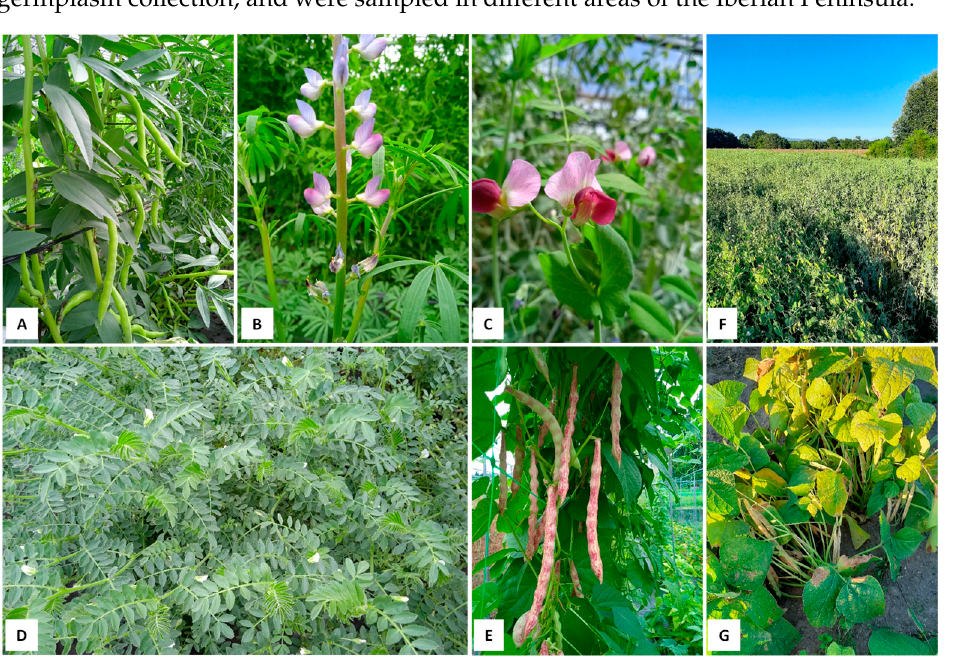
Figure 1. Images of crops in di ff erent environments. ( A – E ) broad bean, lupin, pea, chickpea, and common bean genotypes growing in Environment 1. ( F , G ) Pea and common bean genotypes growing in Environment 2.